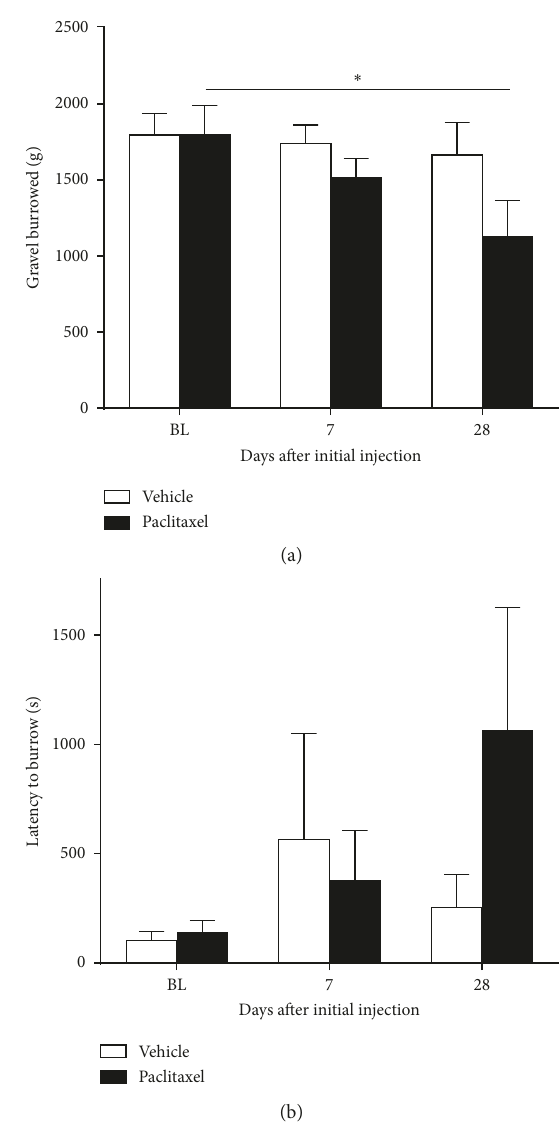
Figure 6: Effect of paclitaxel administration on spontaneous burrowing behaviour. Graphs show the mean SEM of (a) gravel displaced from burrowing tubes and (b) latency to start burrowing by individual rats before paclitaxel/vehicle administration (BL) and ± then on day 7 and day 28 following the initial injection of 2mg/kg paclitaxel or vehicle. 0 . 05, one-way repeated measures ANOVA with Dunnett’s post hoc test comparing the baseline burrowing capacity ( n 6 per (cid:31)